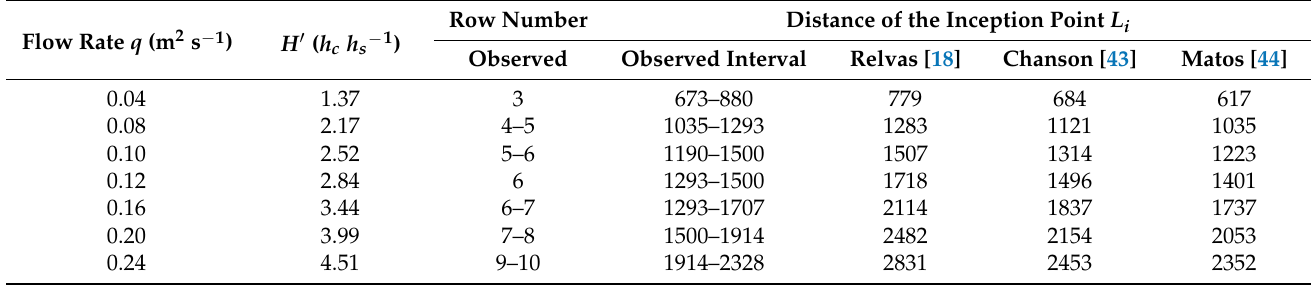
Table 2. The inception point location of tested flows according to different authors.